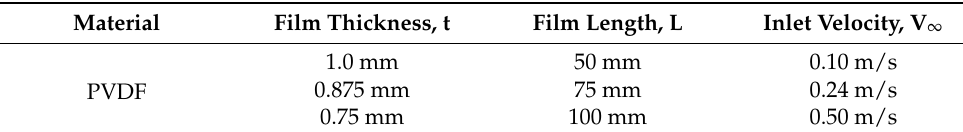
Figure 5. Schematic diagram of the FTEH and dimensions. Table 1. FTEH design parameters.